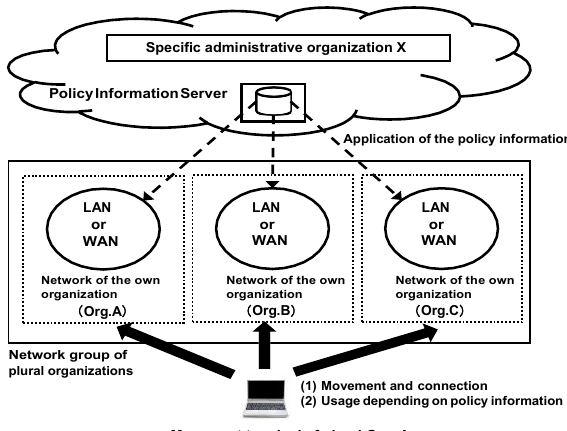
Figure 9. Concept of the proposed